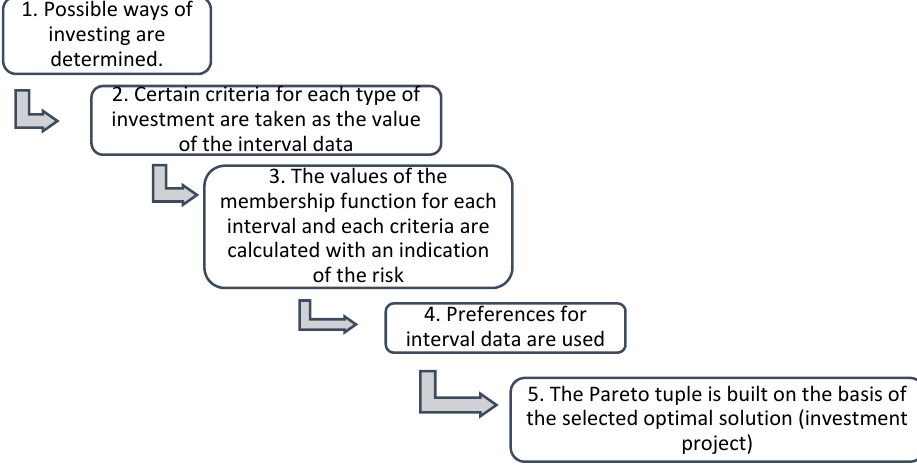
Figure 3. Research